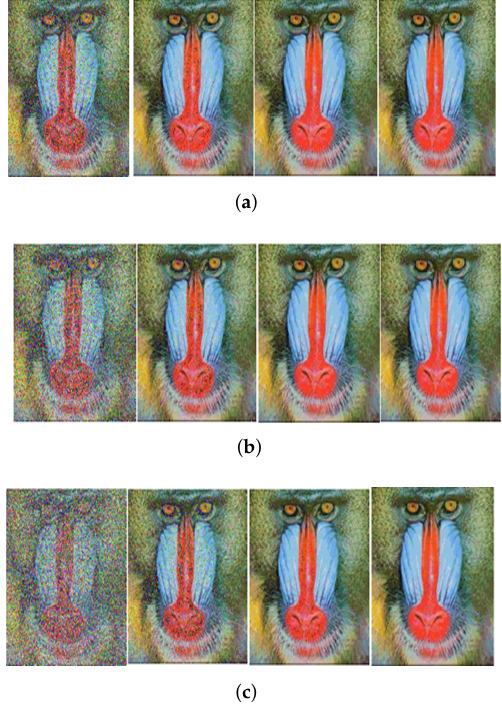
Figure 18. Received image with massive MIMO incorporated DWT-OFDM over a Rayleigh channel, Modulated with 8-PSK and at SNR = 0, 10, 20, 30 dB from Left to Right for different number of users, n . ( a ) n = 10; ( b ) n = 20; ( c ) n = 50.